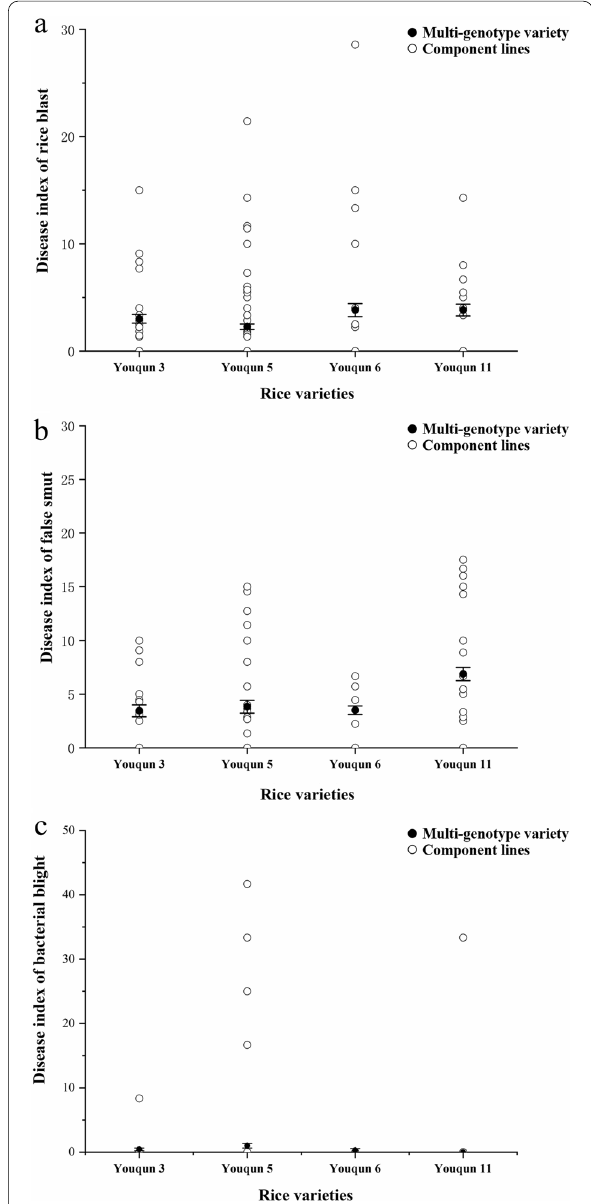
Fig. 1 Comparison of the occurrence of three main rice diseases on multi‑genotype varieties and their component lines. Disease indexes of rice blast ( a ), rice false smut ( b ) and rice bacterial blight ( c ) of multi‑genotype varieties and their component lines. Black hollow circles indicate disease indexes of component lines. Black solid circles indicate disease indexes (mean SD) of multi‑genotype varieties, and ± it was calculated from three independent replicates and analyzed